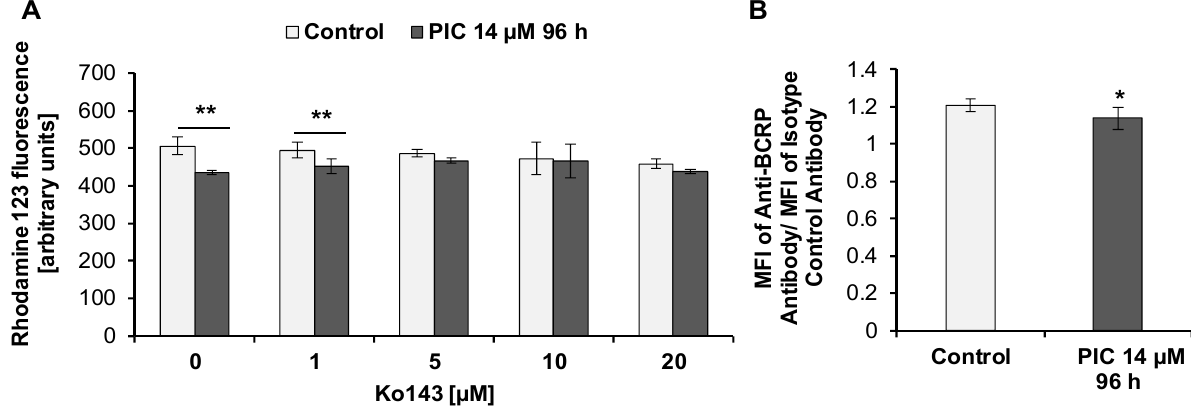
Figure 10. Detection of BCRP in HL-60 cells. Cells were incubated with piceatannol (PIC, IC 90 = 14 µM) for 96 h. ( A) BCRP activity analysis (flow cytometry analysis). Rhodamine 123 uptake/retention assay was performed in the presence and absence of Ko143. Data are presented as means ± SD of three independent experiments in duplicates. ** p < 0.01, statistically significant differences between piceatannol-treated cells and untreated cells, incubated in the absence or presence of Ko143 (One-way ANOVA, Dunnett’s post hoc analysis). ( B) Expression of BCRP in HL-60 cells. Control (untreated cells) and piceatannol-treated cells were stained with anti-BCRP (clone 5D3) antibody or isotype control antibody (flow cytometry analysis). Data are presented as means ± SD of three independent experiments in duplicates. * p < 0.05, statistically significant differences compared to control (Student’s t -test).